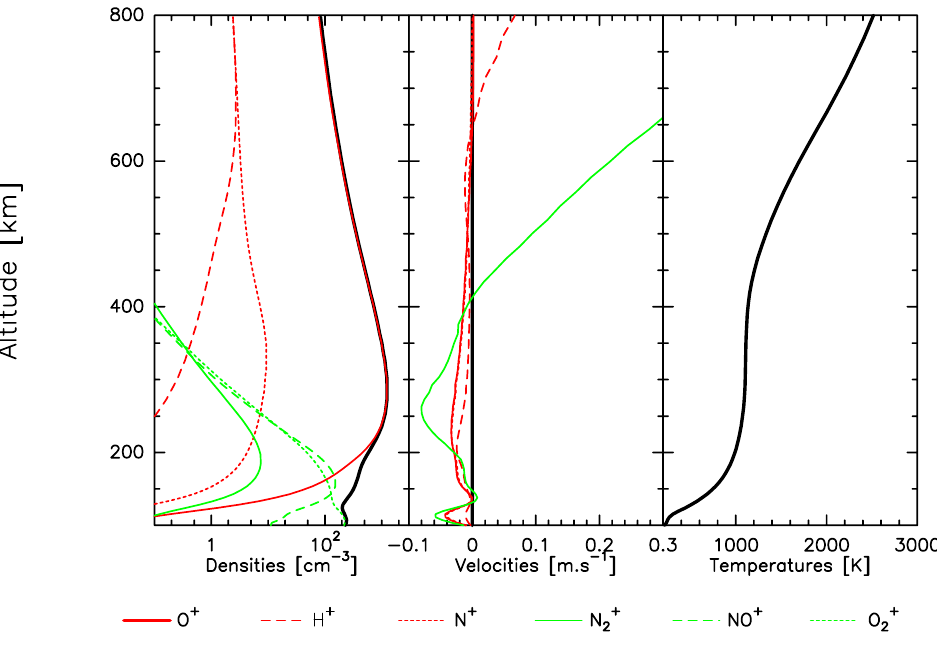
Fig. 1. State of the ionosphere under quiet conditions, as obtained from the TRANSCAR model with: the ion density profile (left panel, the black curve refers to the total density), the ion velocity profile (middle panel) and the electron temperature profile (right panel).